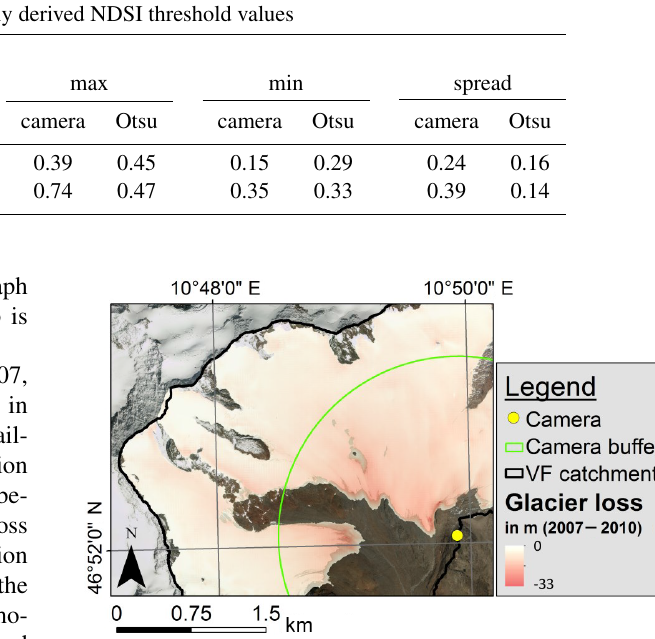
Figure 6. Glacier retreat from 2007 to 2010 causes a loss in eleva- tion of up to − 33m at VF. The green line depicts the buffer distance around the camera which was excluded from the analysis due to sig- nificant glacier loss which in turn led to geometric inaccuracies in the photograph rectification and incorrect NDSI threshold calibra- tion